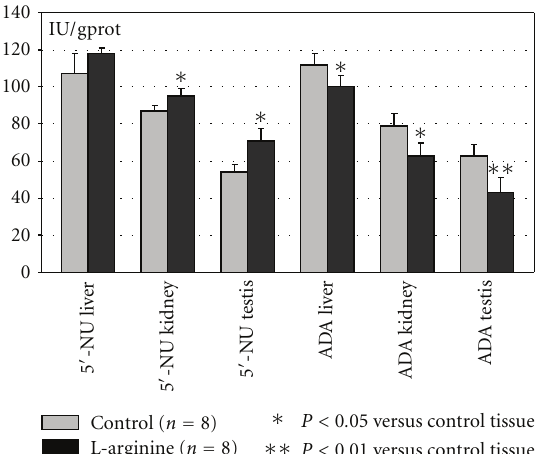
P < 0 . 05 versus control tissue P < 0 . 01 versus control tissue P < 0 . 001 versus control tissue Figure 2: The e ff ect of dietary L-arginine on the activity of AMP deaminase, Xanthine oxidase (XO), and total protein concentration of rat liver, kidney, and testis tissue. The activity of AMP deaminase was determined by measuring the ammonia liberation by using 10mmol/L AMP as substrate. The activity of xanthine oxidase was measured by the formation of uric acid by using 0.05 mmol/L xanthine as substrate. The activity of enzymes was expressed as U/g proteins. Mean values ± SD are given. Each group consisted of 8